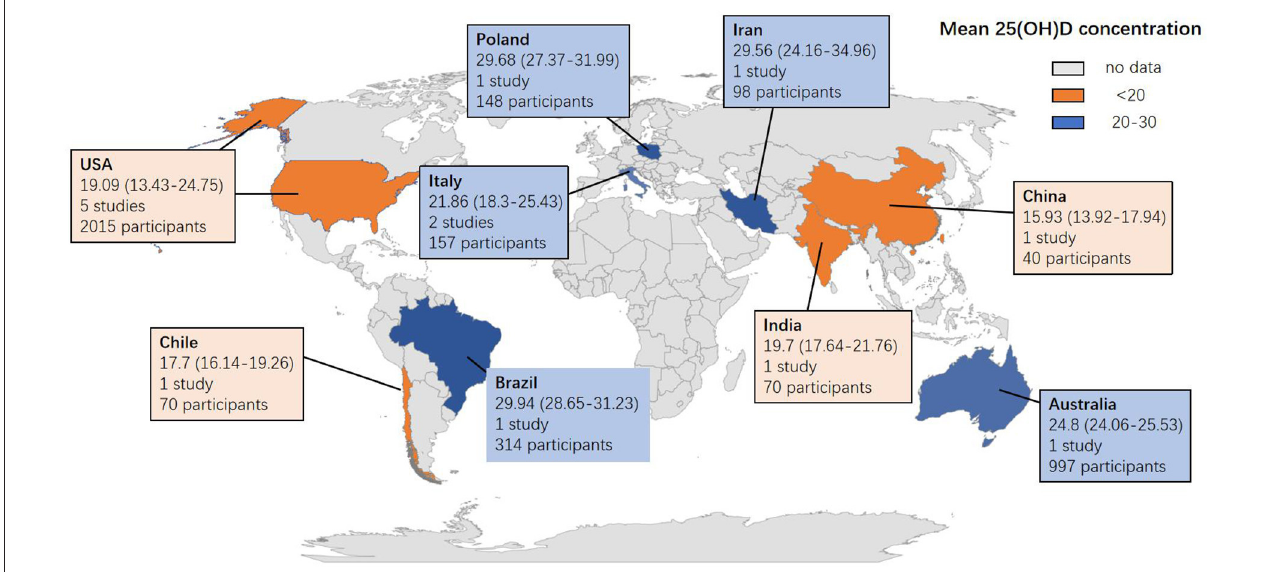
FIGURE 4 | Global map for vitamin D concentration in HIV individuals from 14 included studies. Data are the mean (95% CI) 25 (OH) D concentrations reported in studies done in each country. Pooled means were calculated if the country had more than one study. Twenty five (OH) D